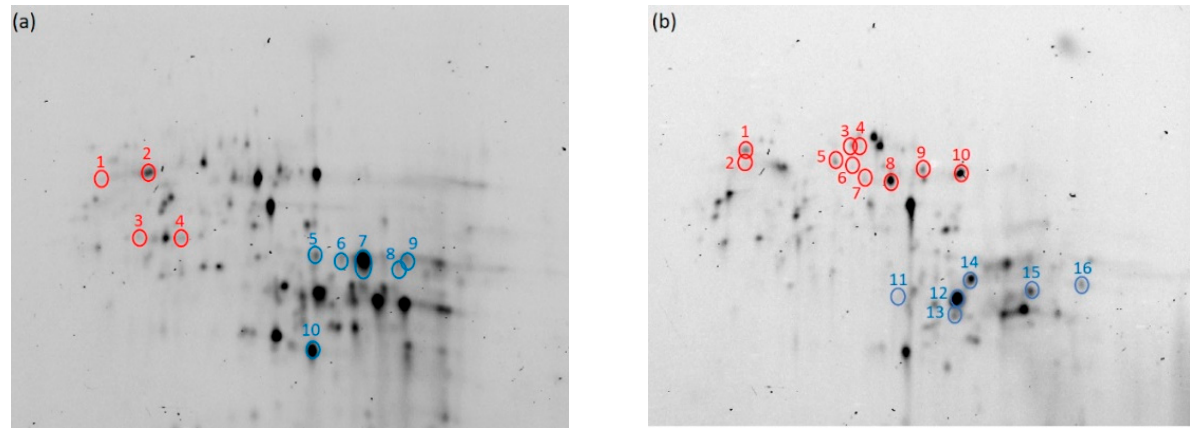
Figure 7. Electrophoretic images of monomeric proteins ( a , b ) in high-protein (HF) and low-protein flour (LF) extracted